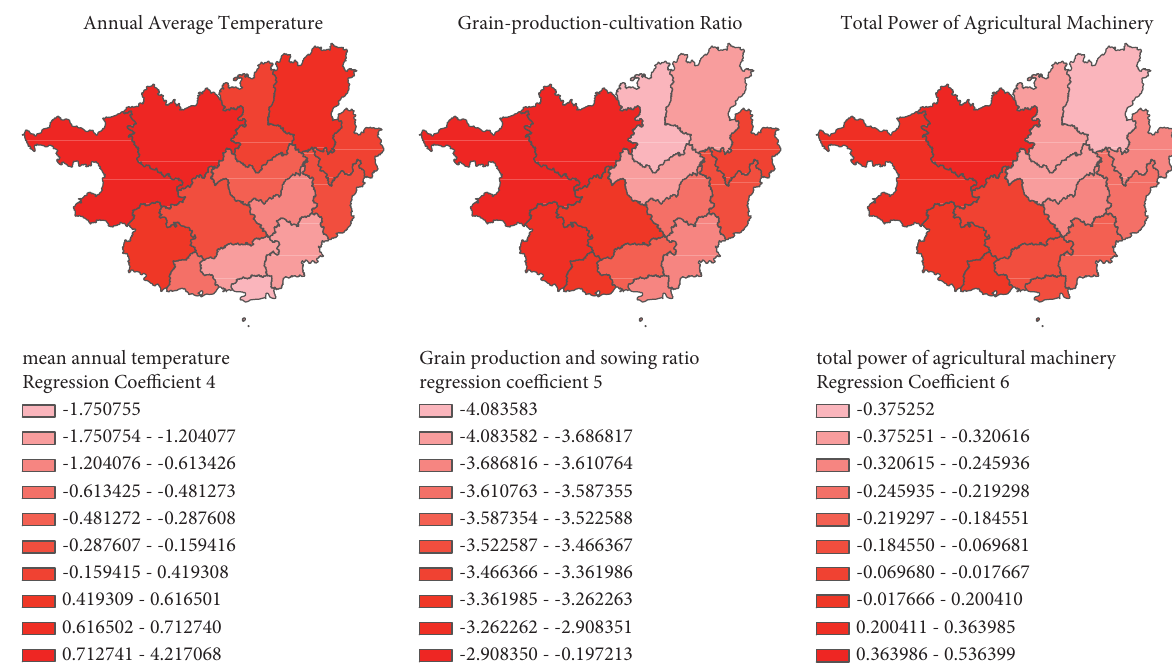
Figure 12: Spatial distribution of regression coefficients of explanatory